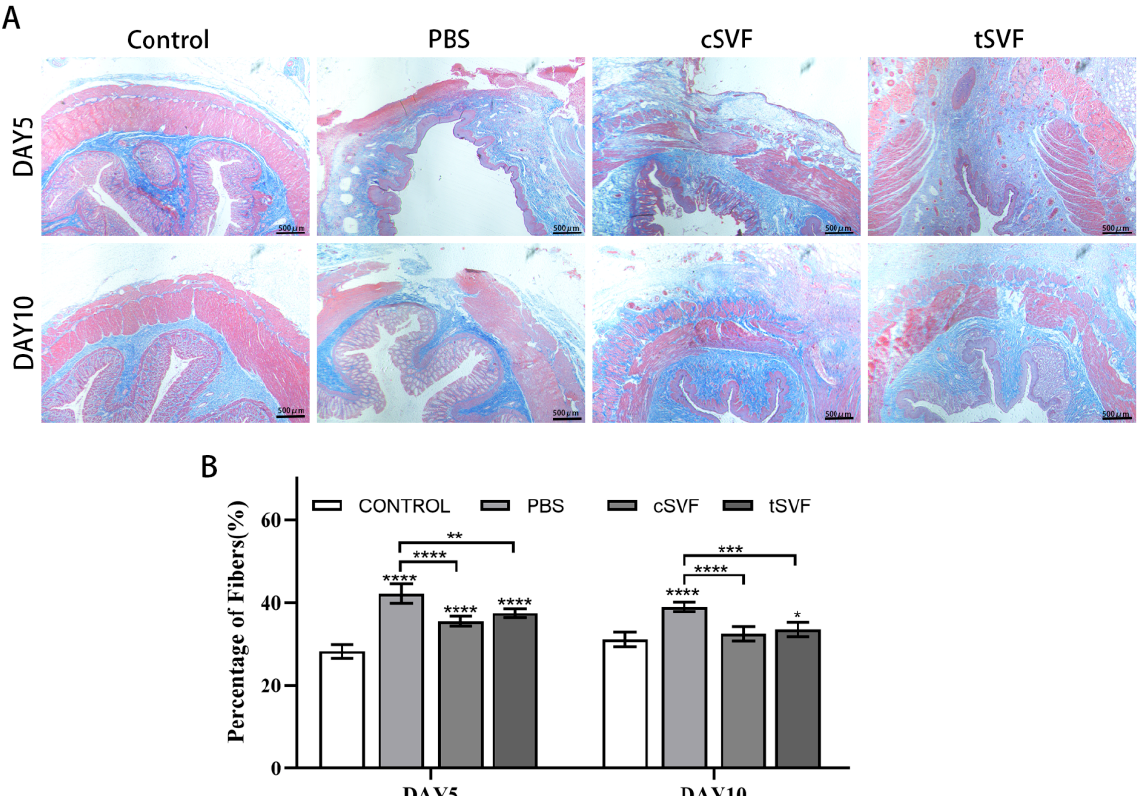
Figure 6. Masson trichrome staining plots ( A ) and fiber scale plots ( B ) of the control group, PBS group, cSVF group and tSVF group at 5 and 10 days after treatment. ‘*’, ‘**’, ‘***’, ‘****’ represent statistically different as p < 0.05, p < 0.01, p < 0.001, p < 0.0001, respectively. Those with horizontal lines represent statistical differences from the ends of the horizontal lines, and those without horizontal lines are statistically different compared with the control group.